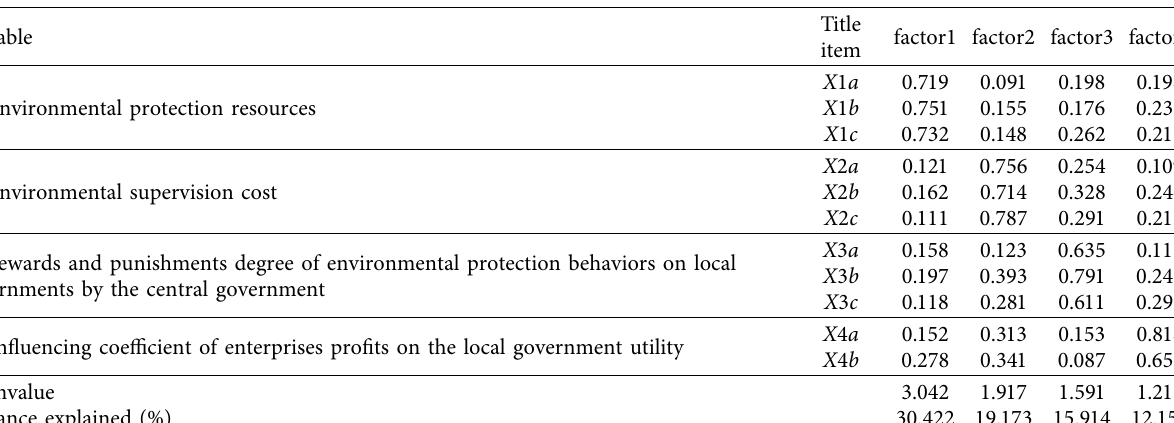
Table 6: Exploratory factor analysis results of government environmental protection